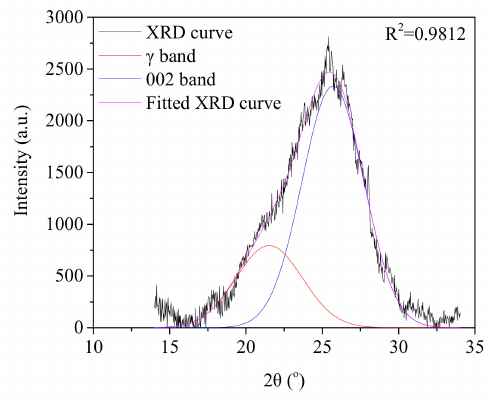
Figure 1. Curve-fitting XRD spectrum of (002) peak for SA